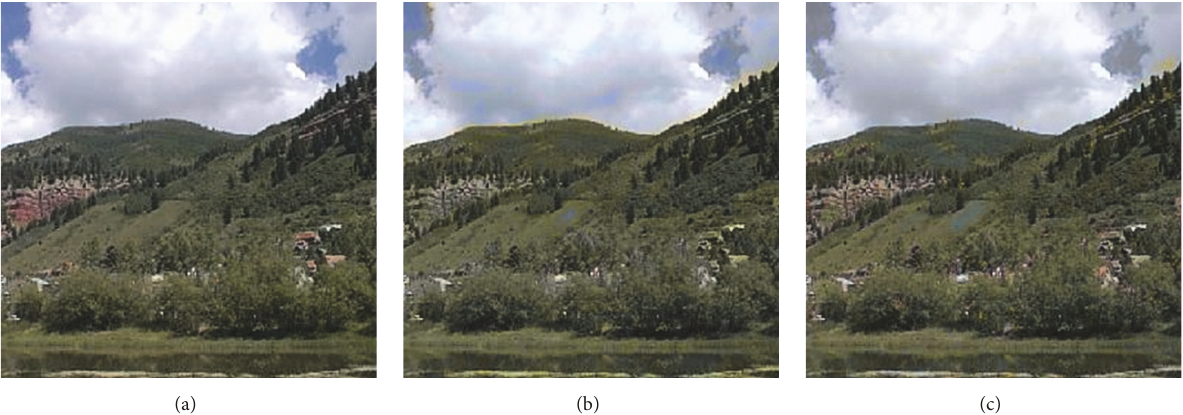
Figure 4: An extra feature tuple added after M-step to make learned feature more descriptive. As depicted in this image, the recovered image using three-dimensional feature (b) misses some colors from original image (a), and these defects have been eliminated after adding extra feature in M-step (c).